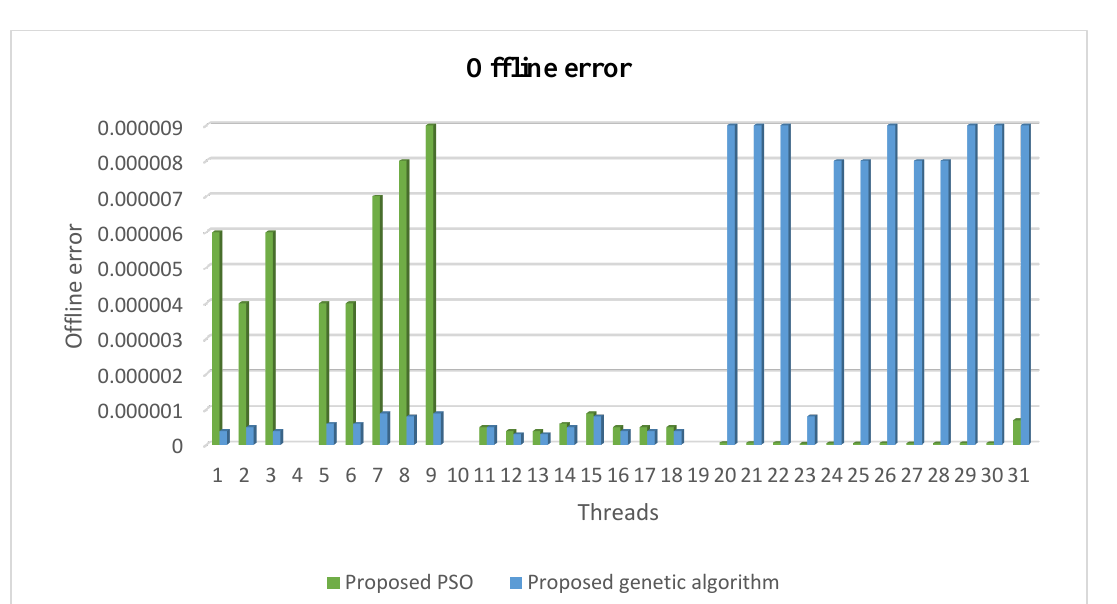
Figure 3. Offline error comparison.